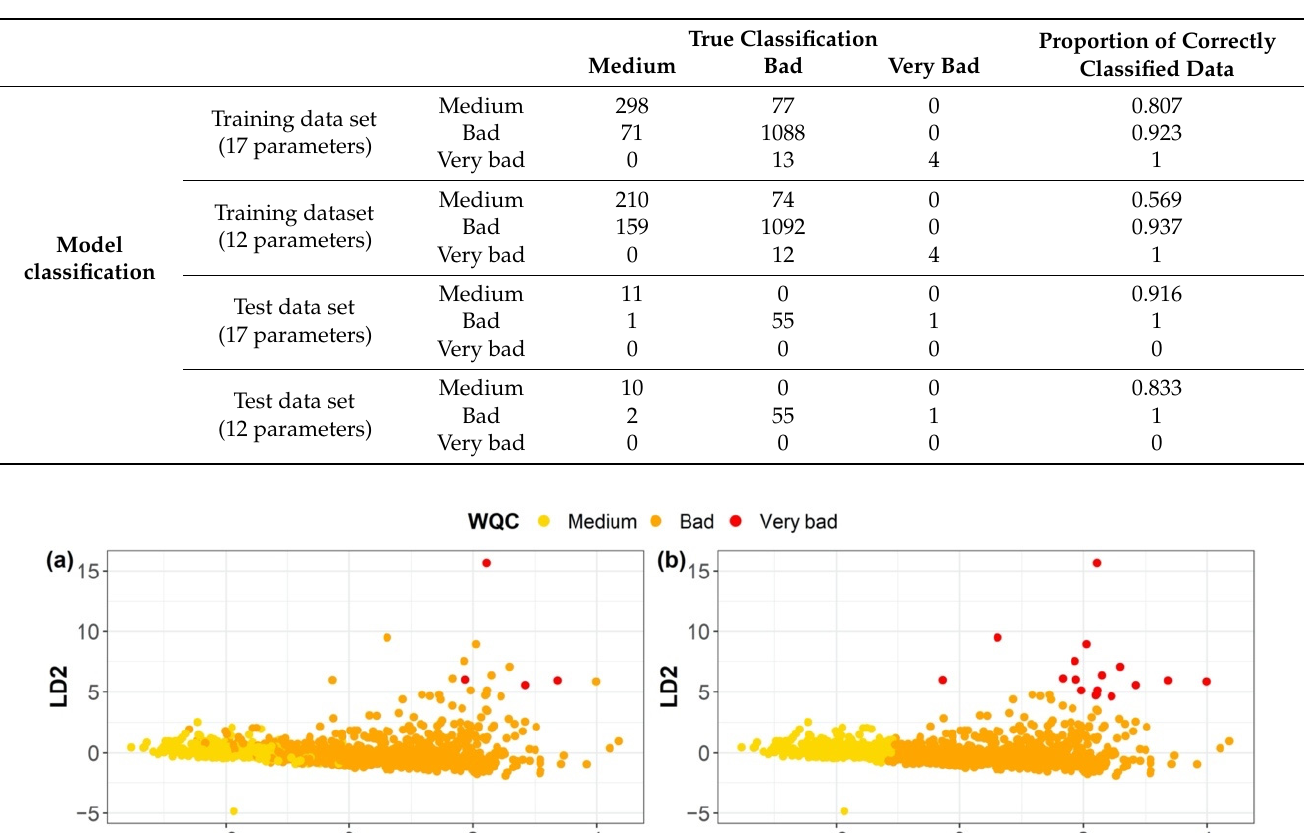
Table 6. Summary of discriminant analysis model.